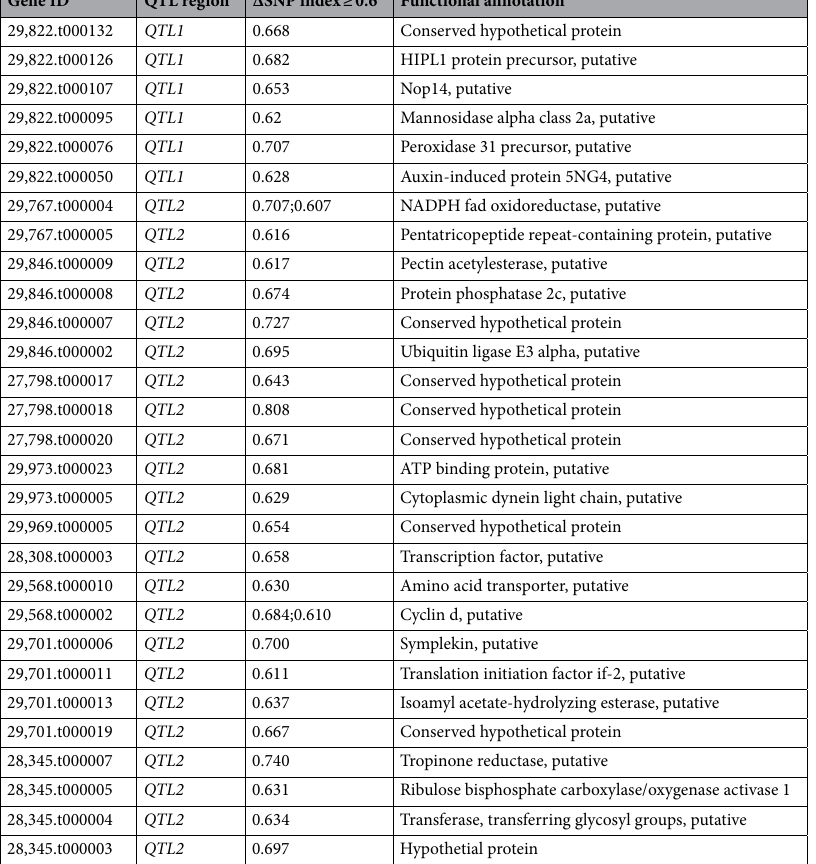
Table 2. The candidate genes potentially controlling plant height in castor bean identified in